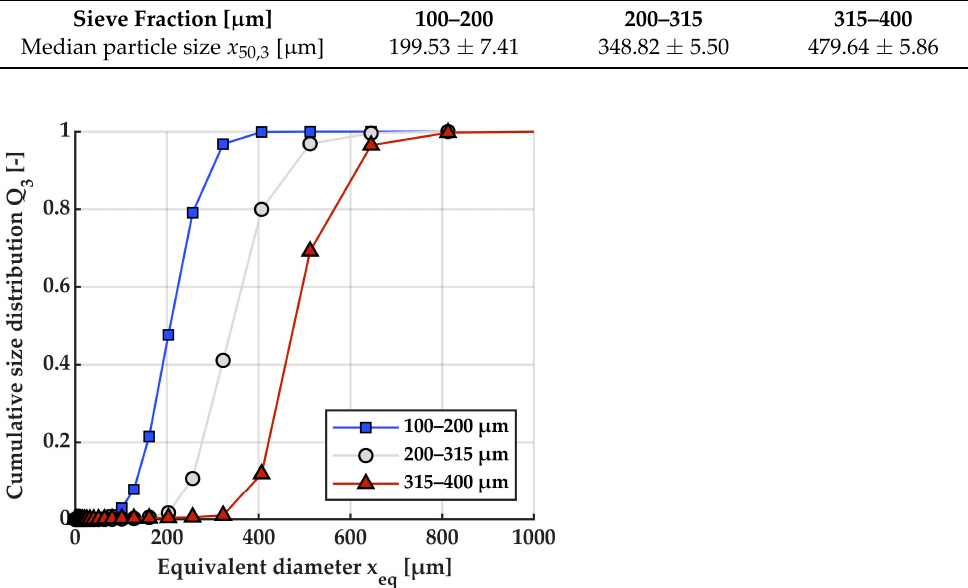
Figure 1. Exemplary cumulative PSDs of the employed L -alanine particle fractions after wet sieving.